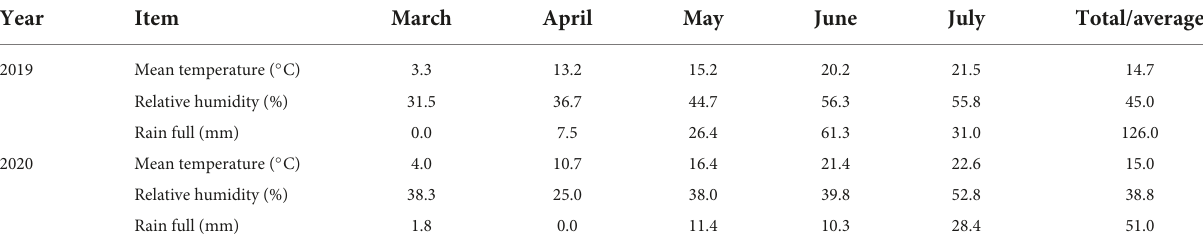
TABLE 1 The in-growing-season weather data in 2019 and 2020 at Wuwei Experimental Station, northwestern